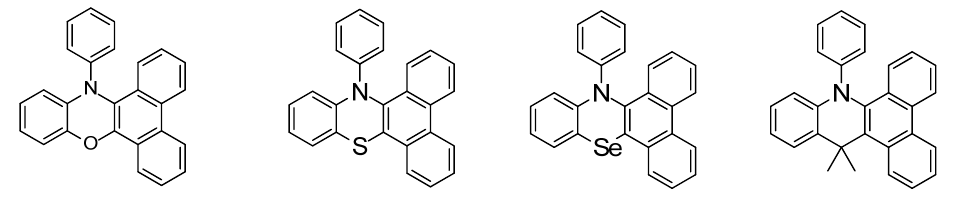
Figure 5. Structures of the acridine from the report by Chen et al.